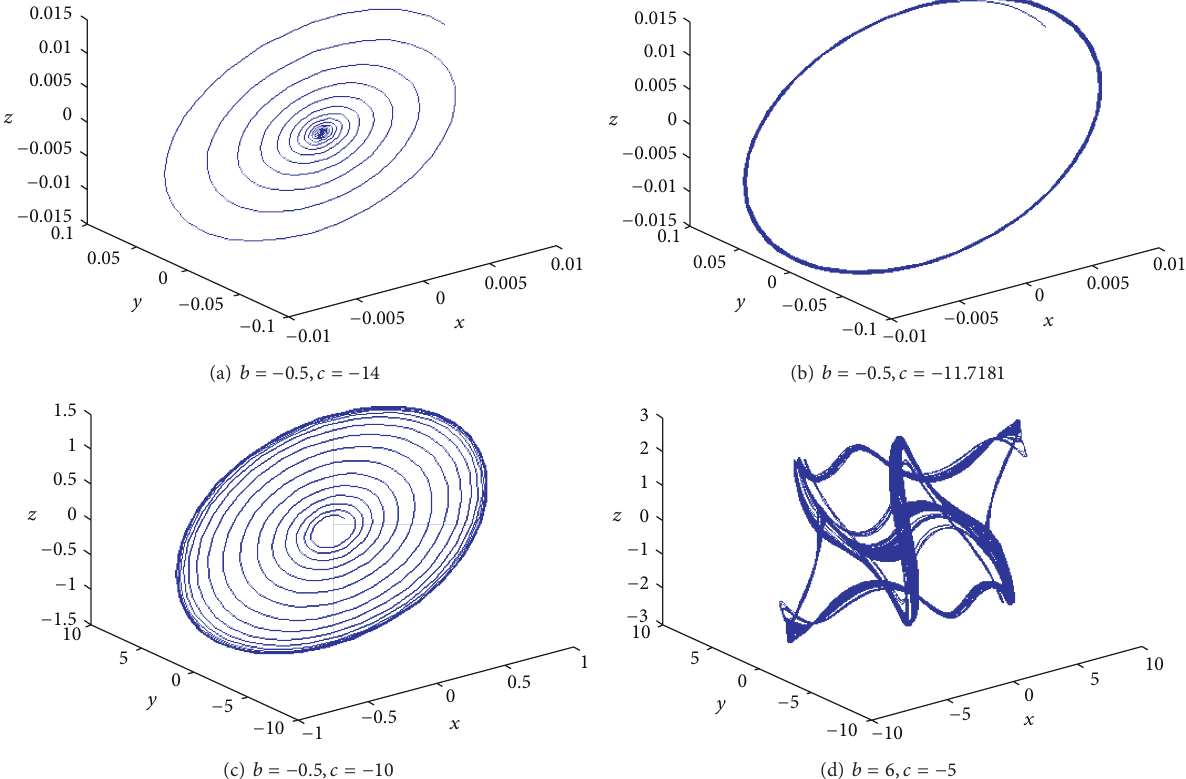
Figure 9: Phase diagram of system (3) with different